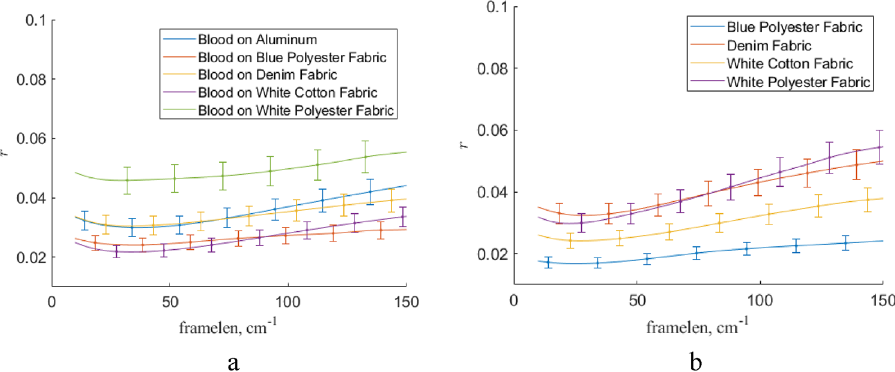
Figure 12. The dependence of r on the gliding spectral window for Raman spectra of blood on various substrates processing by Savitsky-Goley filter ( a ) and the same for pure substrates ( b ). Here, the first-order polynomial was used in this filter implementation. Here, “framelen” parameter means the gliding spectral window.